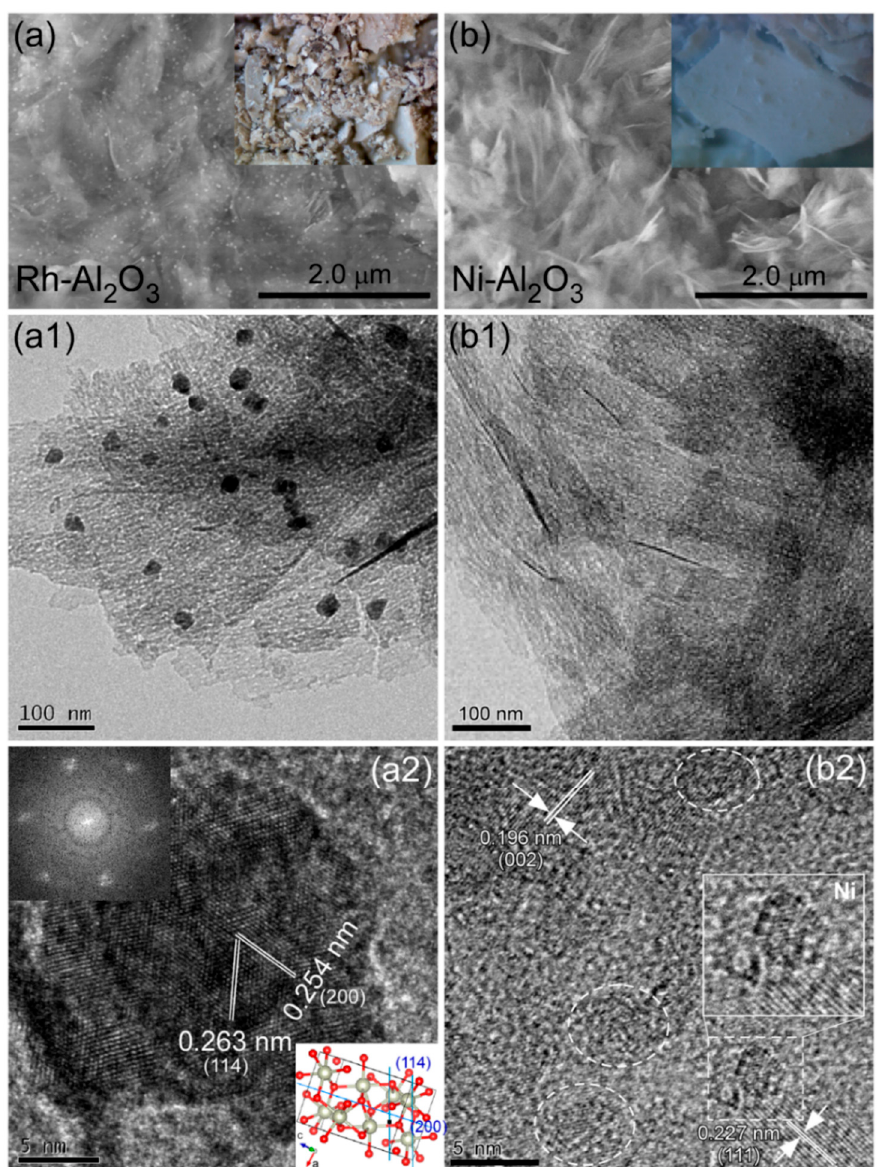
Figure 2. SEM ( a , b ), TEM ( a1 , b1 ), HRTEM ( a2 , b2 ) images of selected Rh-Al 2 O 3 ( a , a1 , a2 ) and Ni- Al 2 O 3 ( b , b1 , b2 ) nanosheets. Insets of Figure 2(a2) show the fast Fourier transform (FFT) pattern of the HRTEM image, and the structure projection of the (114) and (200) planes for Rh 2 O 3 . For the XRD patterns of Pd-Al 2 O 3 nanosheets, several peaks at 2 θ = 33.8°, 42.0°, 54.7°, 60.1°, and 71.5° showed good matches with the (011), (110), (112), (013), and (121) crystal planes of tetragonal (p 42/mmc) PdO (ICSD ref. 98-002-9281), respectively [13]. For Ir-